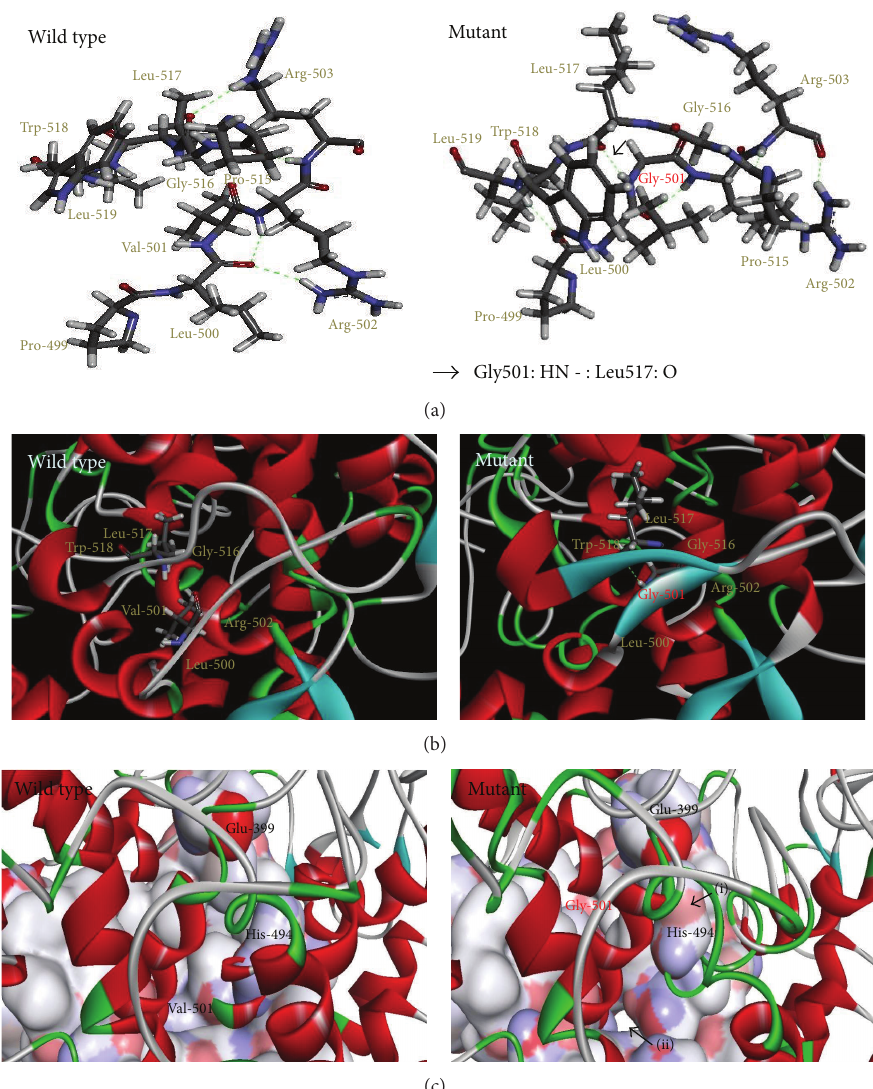
Figure5:ComputergeneratedmodelsofthewildtypeandmutantTPO.(a)ResiduesPro-515toLeu-519andPro-499toArg-503aredisplayed in sticks for wild type and p.Val501Gly mutant TPO proteins. H-bonds are shown as green dashed lines. For the mutant protein, H-bond Gly501: HN -:Leu517: O is indicated by an arrow. (b) Ribbon presentation of wild type and p.Val501Gly mutant TPO proteins. The residues Val-501, Gly-501, and Leu-517 are shown as sticks. The H-bond between the backbone oxygen of Leu-517 and amide hydrogen of Gly-501 in the mutant contributed to the formation of a beta sheet that comprised two beta strands from Leu-500 to Arg-502 and Gly-516 to Trp-518. (Red areas represent alpha helix, cyan shows the beta-pleated sheet areas, gray areas represent coils in the protein, and green areas represent the turn.) (c) Connoly surface representation of the internal surface of TPO proteins and the binding site of heme (Glu-399) and iron (His- 494) in wild type and p.Val501Gly mutant. Residues on the top layer are shown as ribbon to allow the visualization of the binding pocket. Significant structural alterations are indicated by arrows: (i) conformational changes in the heme/iron binding pocket and (ii) small “opening” from external surface. The Connolly surface is coloured according to electrostatic potential